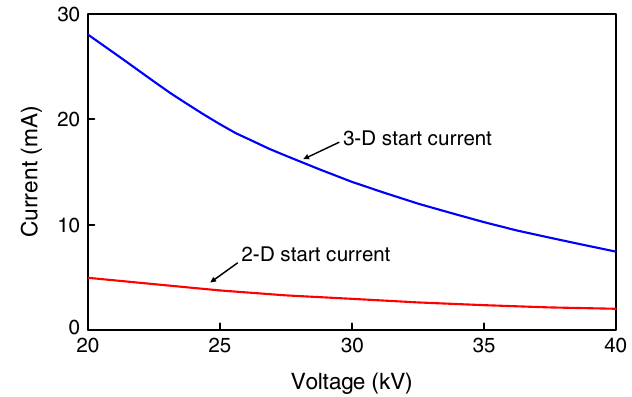
FIG. 8. (Color) Start current for the parameters of Table